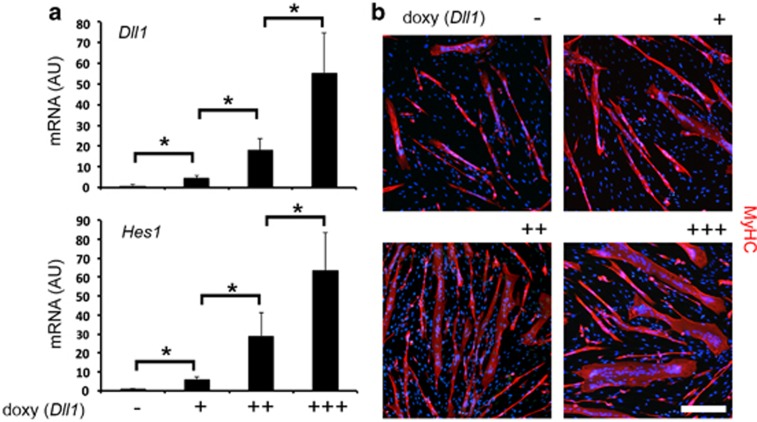
Dll1 dose-dependently enhances in vitro myogenic ability of Sgcb-null cardiac MABs. (a) According to increasing concentrations of doxycycline, expression levels of Dll1 and Hes1 are significantly upregulated at 72 h post transduction (*P<0.05; n=6). Expression levels are reported in arbitrary units (AU) as fold change versus transduced MABs in absence of doxycycline. Data in charts are depicted as mean±standard deviation. (b) Immunofluorescence staining at day 7 of differentiation shows enhanced in vitro myogenic ability, following increasing concentrations of doxycycline, applied till day 3. Scale bars indicate 100 μm